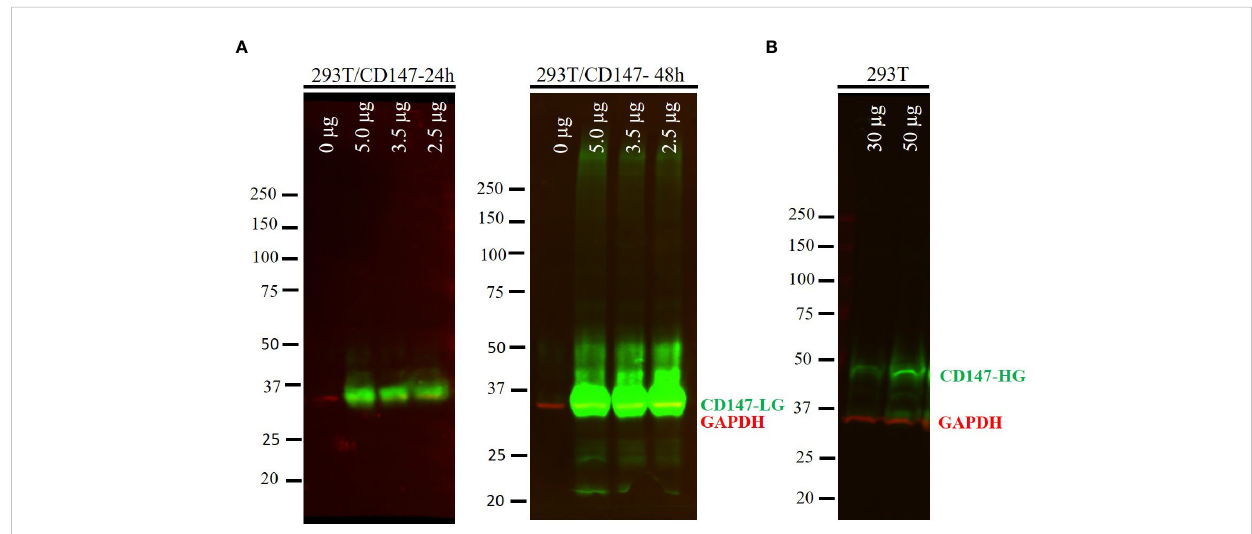
FIGURE 2 Protein expression of CD147 in HEK 293T cells. (A) HEK 293T cells transfected with different amounts of a plasmid expressing the CD147 protein (0, 2.5, 3.5 and 5.0 µg). Whole cell lysates were harvested at 24 and 48 h post-transfection and analysed by Western blotting. Proteins were loaded at 25 µg per line. (B) Endogenous expression of CD147 in HEK 293T cells was detected loading 30 and 50 µg of the whole cell extract. Low glycosylated CD147 (CD147-LG, ~32 kDa), high glycosylated CD147 (CD147-HG, ~42 kDa). GAPDH (34 kDa) was used as a loading control. Overlay of the simultaneous detection of CD147 (800 nm channel-green) and GAPDH (700 nm channel-red) fl uorescent signals.